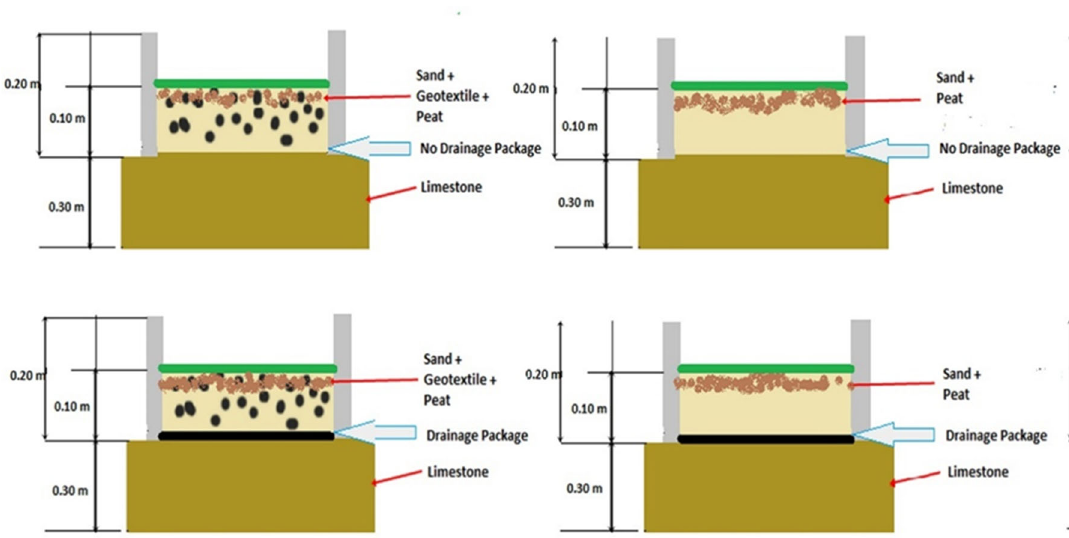
Figure 1. Scheme of boxes design, including the depth of the top cushion material consisting of sand (G1), or sand with geotextile (G2 = 2 (cid:2921)(cid:2917)